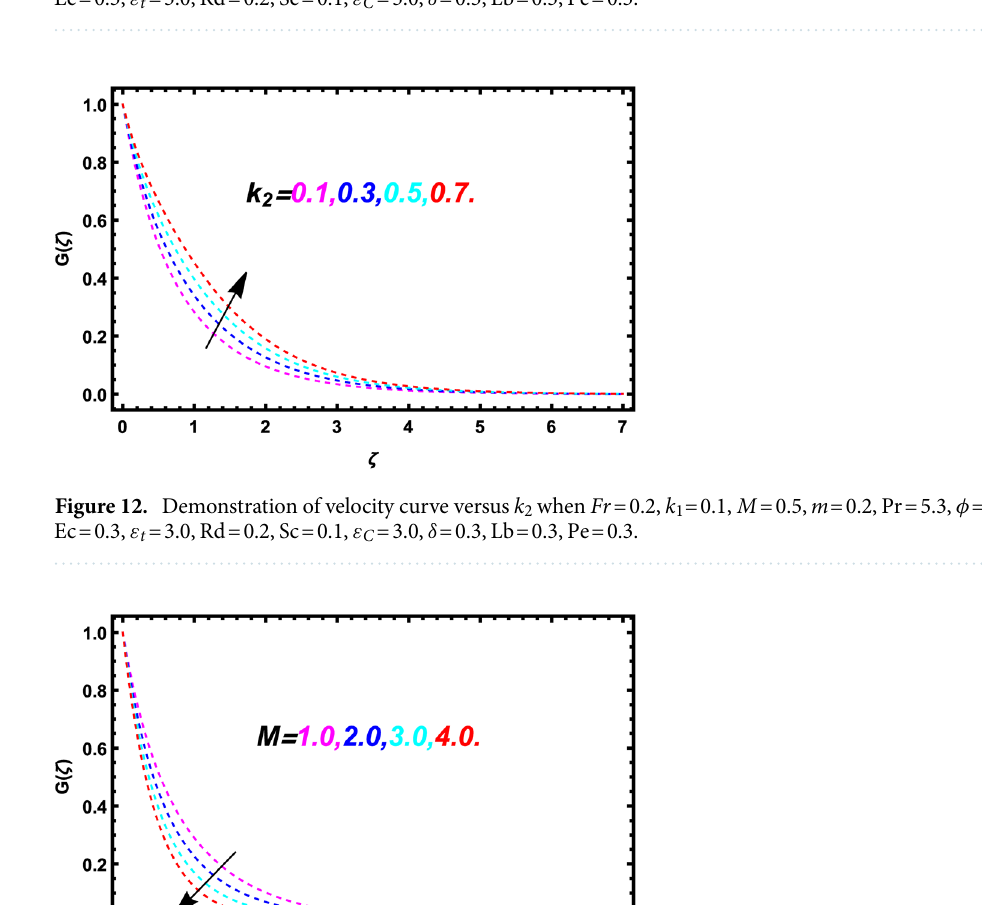
Figure 11. Demonstration of velocity curve versus k 1 when Fr = 0.2, k 2 = 0.3, M = 0.5, m = 0.2, Pr = 5.3, φ = 0.01, Ec = 0.3, ε Rd = 0.2, Sc = 0.1, ε Lb = 0.3, Pe = 0.3. t = 3.0, C = 3.0, δ = 0.3,